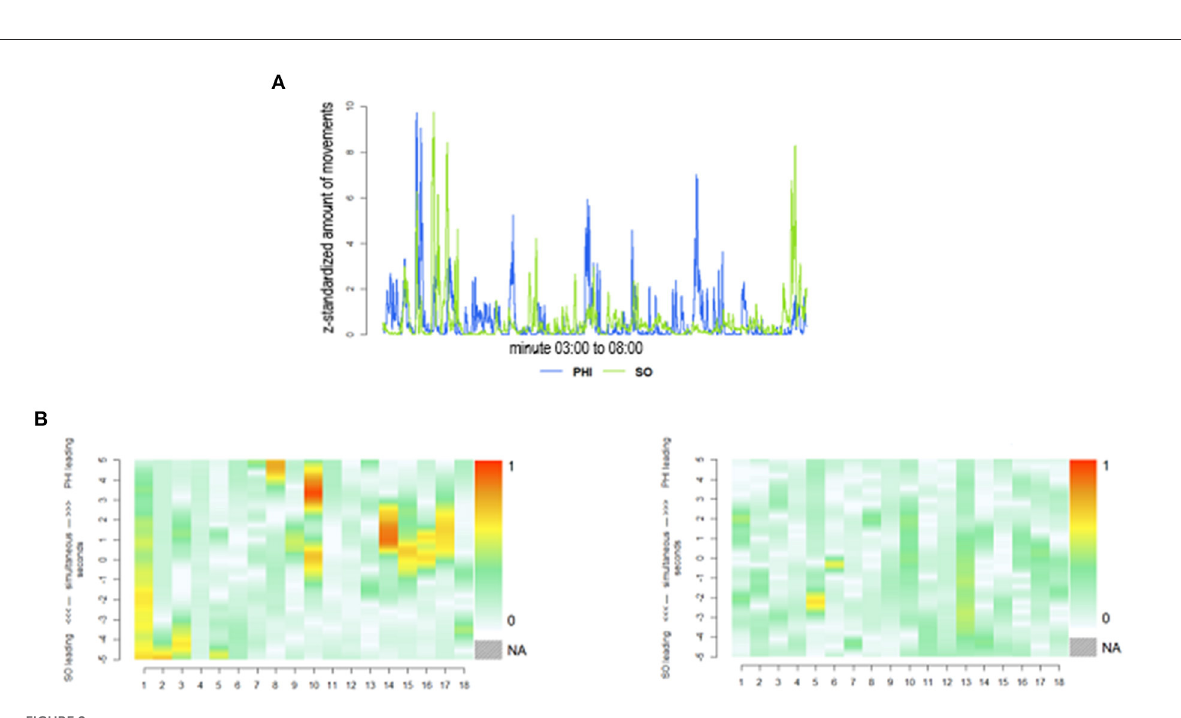
FIGURE2 (A) Movements of PHI in blue and of SO in green. PHI, people with hearing impairment; SO, significant other. (B) Synchronization over time. Examples of dyads with high synchrony, and of dyads with low synchrony. x-axis = time segment of 30s, y-axis = lags; 0 = synchronic movement, 0–5 = PHI leading, 0 to − 5 = SO leading. The more the color turns into orange, the higher the correlation. PHI, people with hearing impairment, SO, significant